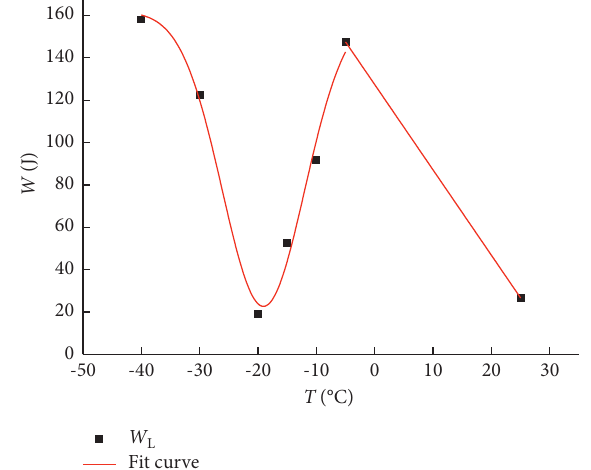
Figure 16: Dissipated energy vs. temperature.